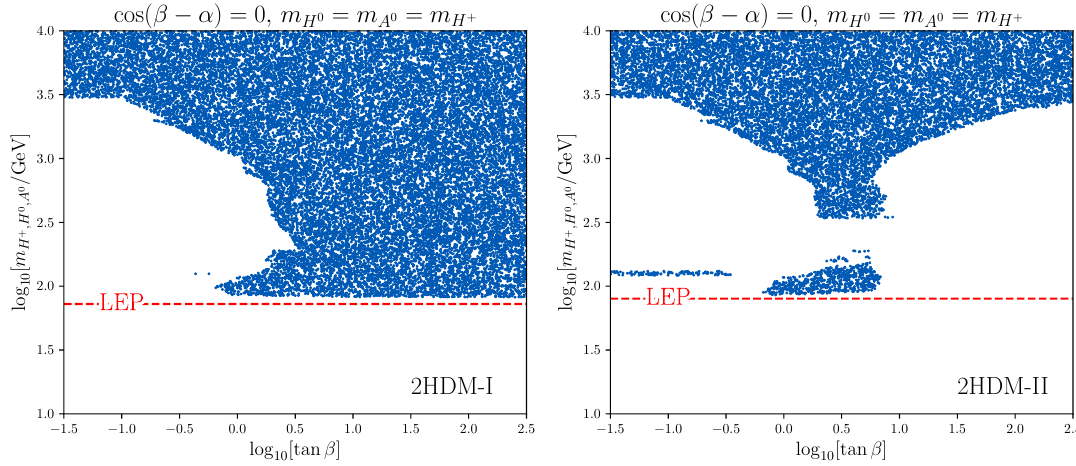
Figure 12 . Scan of 50000 randomly generated points compared against LHC data using 2HDecay and HiggsBounds , with allowed points shown in blue. On the left, the scan in the 2HDM-I, on the right the